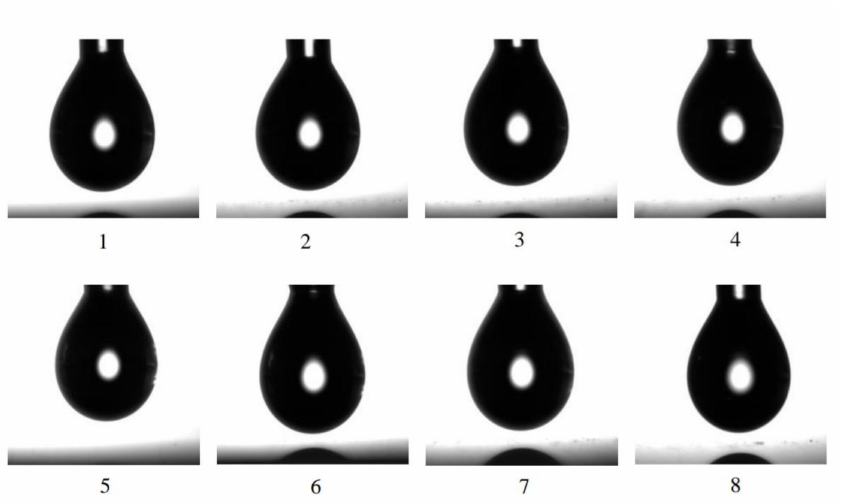
Figure 4. Images of droplets characteristic of each sample, captured at the time of evaluation of γ LG at 35 ◦ C.